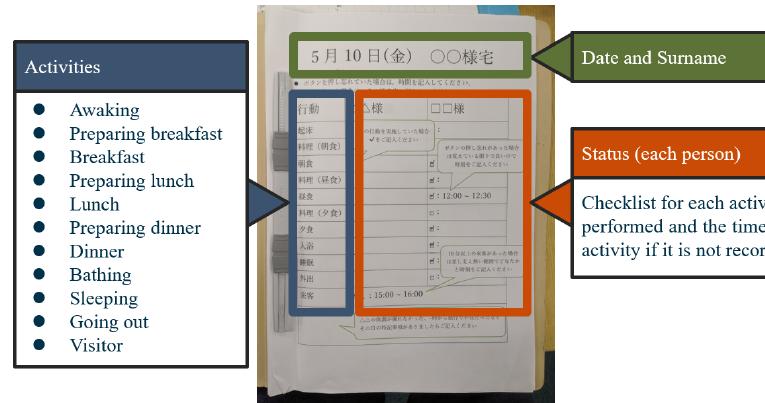
Figure 4. Daily questionnaire.